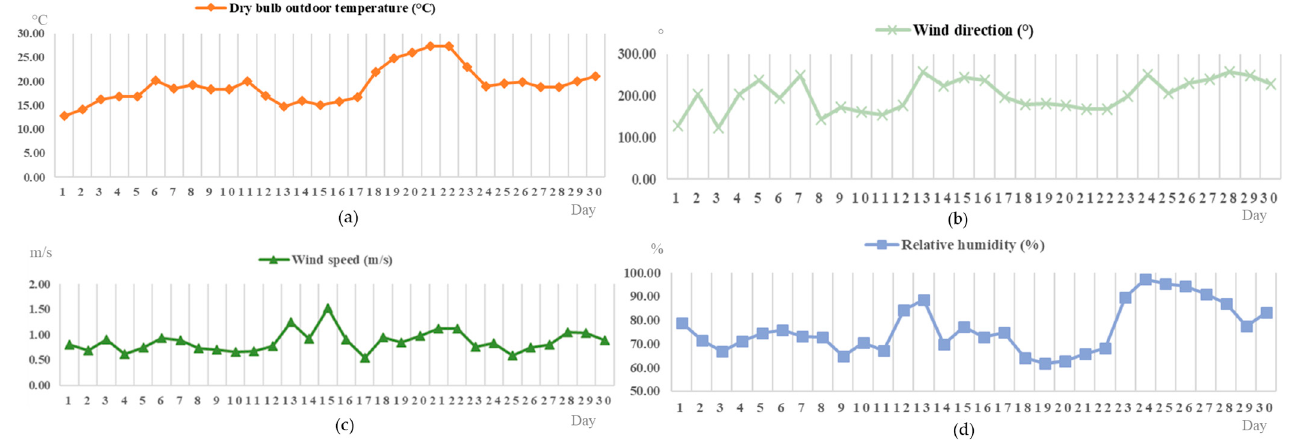
Figure 4. Microclimatic data of the campus, June 2021. ( a ) Dry bulb temperature, ( b ) Wind direction, ( c ) Wind speed, and ( d ) Relative